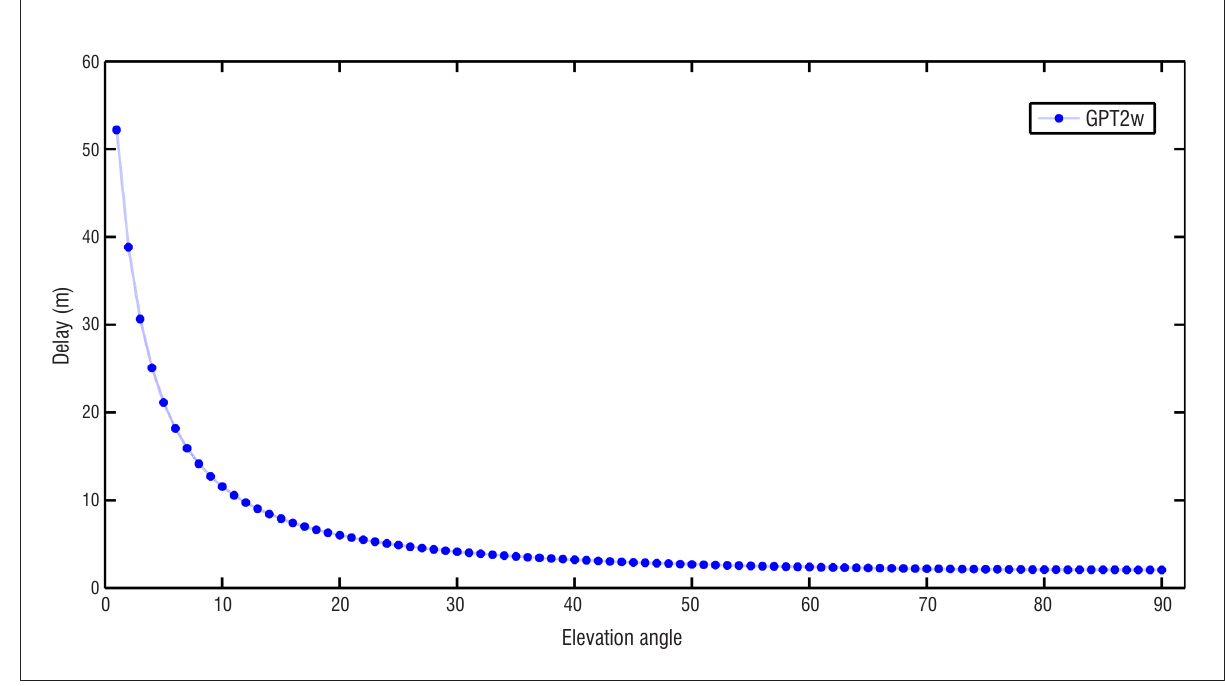
Figure 5 : Slant delay as a function of elevation angle for the HartRAO site, computed for the day of 30 June 2015, using Böhm et al.’s 40 GPT2w model.